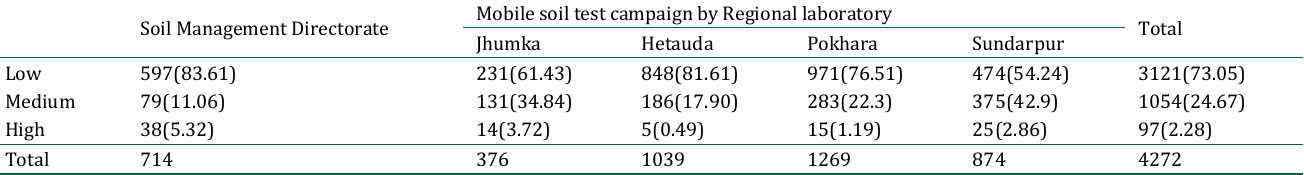
Status of soil organic matter obtained in mobile soil test campaign in Nepal conducted by various laboratories for fiscal year 074/75 Soil Management Directorate